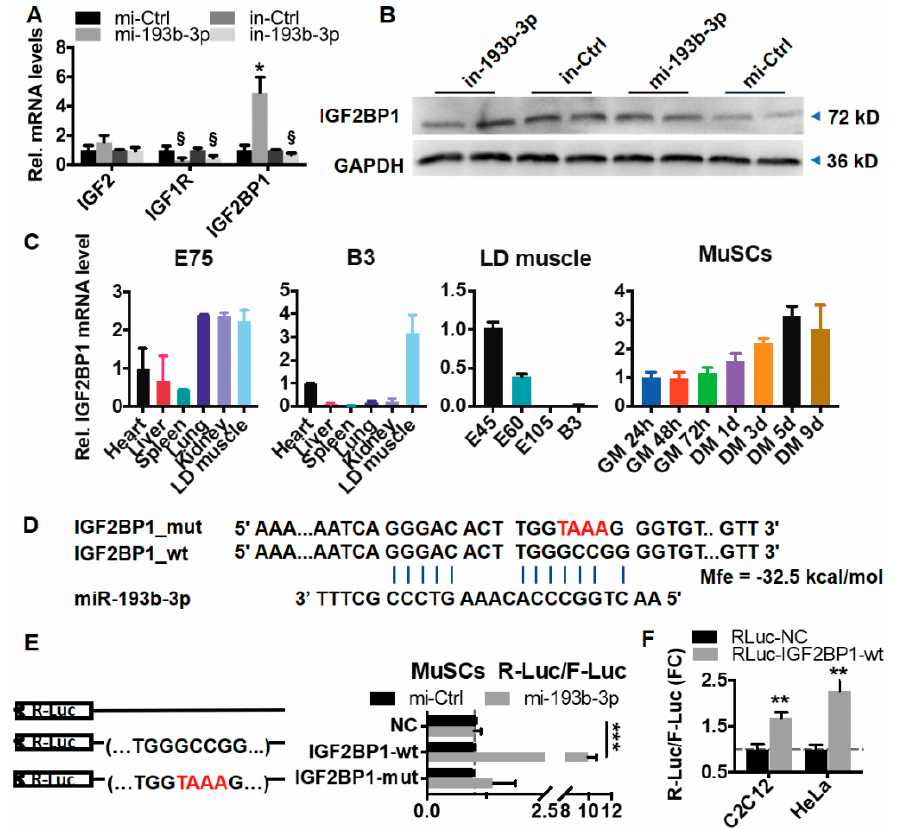
Figure 3. miR-193b-3p induces IGF2BP through a seed-sites match. ( A ) miR-193b-3p promotes IGF2BP1 transcripts. ( B ) miR-193b-3p elevates IGF2BP1 protein. Western blotting (WB) assay was performed to detect IGF2BP1 protein. GAPDH works as a loading control. ( C ) The expression pro- file of IGF2BP1 in goat tissues and cells. ( D ) miR-193b-3p targets 3 ′ UTR of IGF2BP1. The potential seed match between miR-193b-3p within 3 ′ UTR regions of IGF2BP1 is predicted. The blue line marks the complementary nucleotide. Mfe indicates free energy between IGF2BP1-wt and miR- 193b-3p. ( E ) The addition of miR-193b-3p activates luciferase activity of wild-type (R-Luc-IGF2BP1-